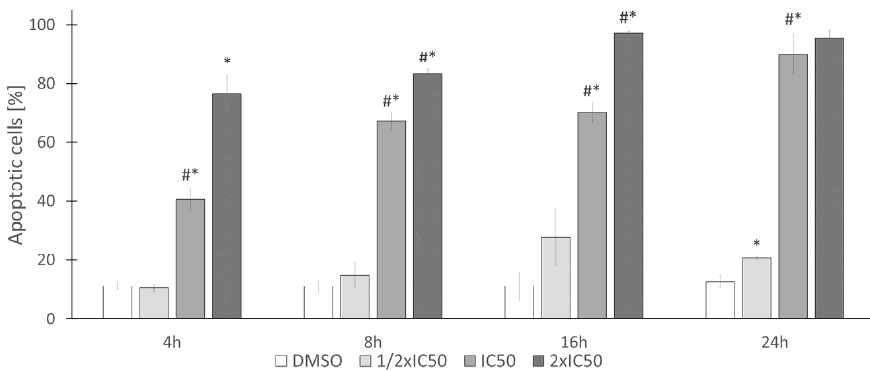
Figure 10. Rinderol proapoptotic activity expressed as a percent of apoptotic HeLa cells (sum of early apoptotic An + PI − and late apoptotic An + PI + cells) after exposure to studied compound. Data are the means ± SD of at least three independent replicates. Asterisk (*) indicates statistically significant differences ( p ≤ 0.05) between consecutive rinderol concentrations within the same incubation period (DMSO—0.4%, 1/2 IC 50 —2.83 μ g/mL, IC 50 —5.66 μ g/mL, 2 × IC 50 —11.32 μ g/mL). Grids (#) indicate results which were significantly different ( p ≤ 0.05) in comparison to the previous time point of the same rinderol concentration.